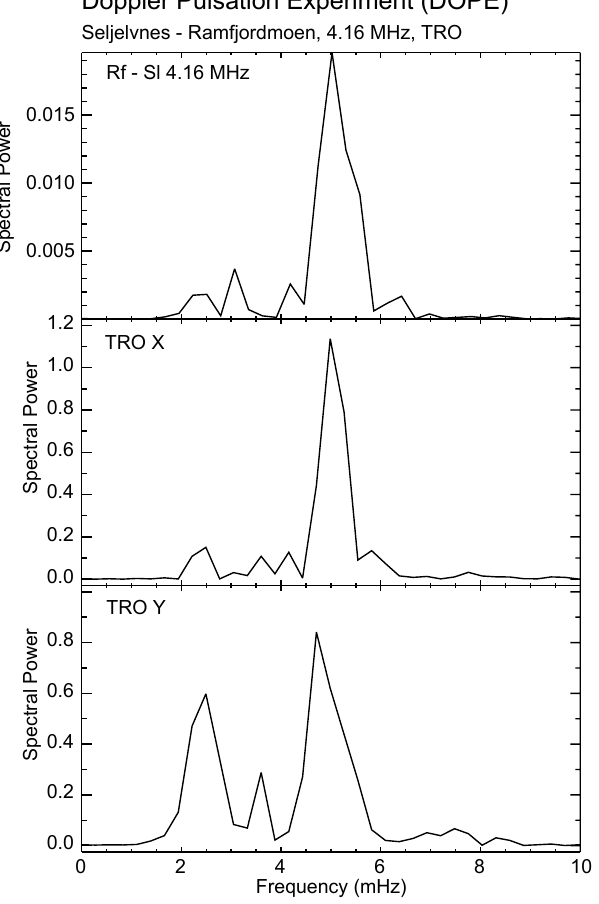
Fig. 5. Power spectrum of the magnetometer and DOPE data shown in Fig. 4.